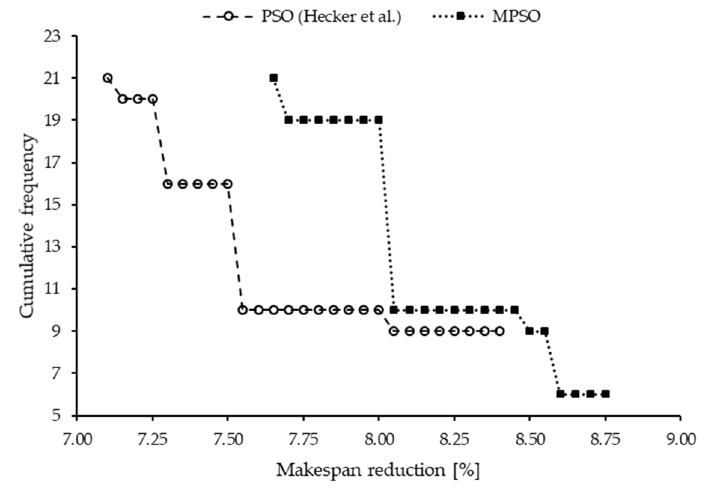
Figure 13. Performance comparison of particle swarm optimization (PSO) implemented by Hecker et al. [6] with modified PSO (MPSO) to optimize the makespan of problem II.